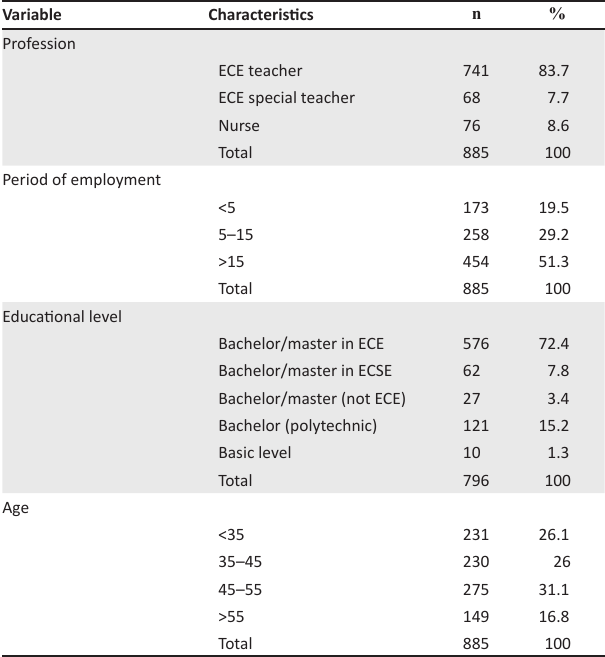
TABLE 1: Descriptive statistics of ECP’s background characteristics.